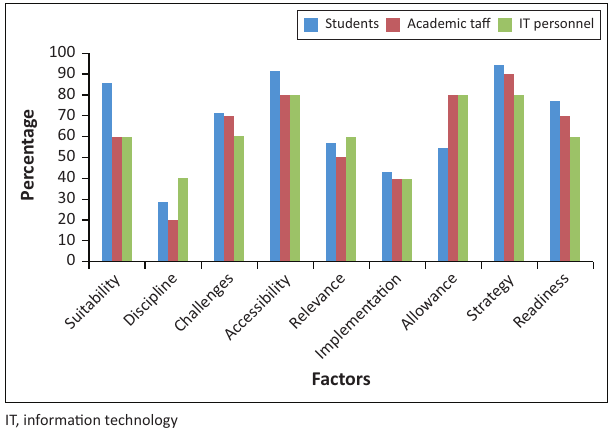
FIGURE 1: Overall indicators of ‘bring your own device’ readiness